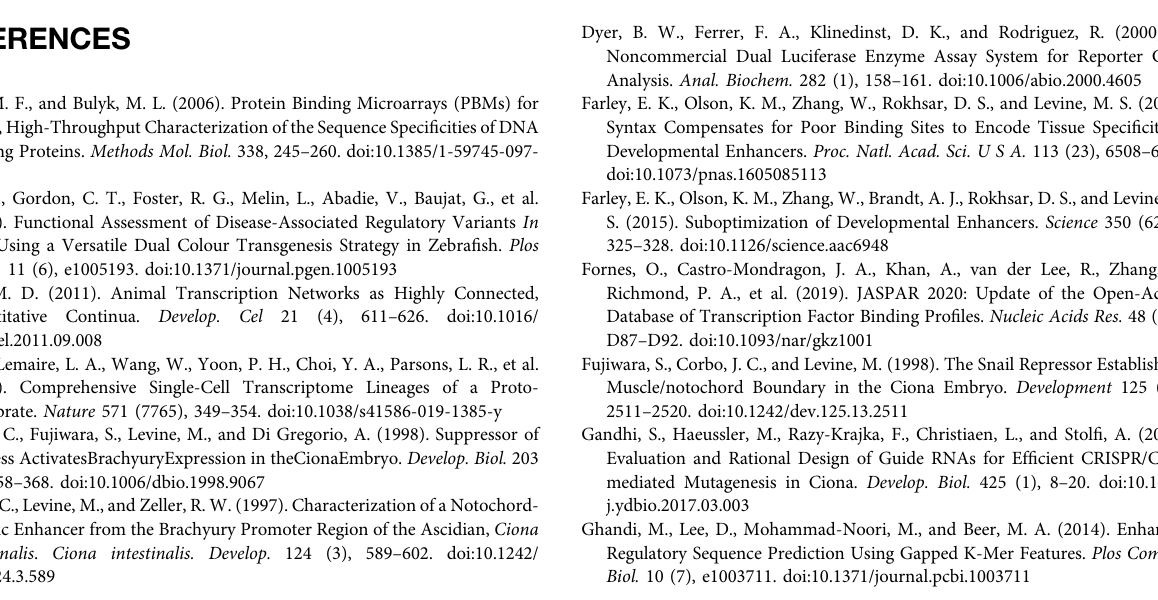
Supplementary Table S1 | Pairwise comparisons using t-tests with pooled SD for data of screening for mutation effect on major TFBSs predicted on Bra proximal enhancer. Red p -value < 0.05. Supplementary Table S2 | Pairwise comparisons using t-tests with pooled SD for data of determination of baseline and comparison between baseline and constructs with severe effect. Red p -value < 0.05.